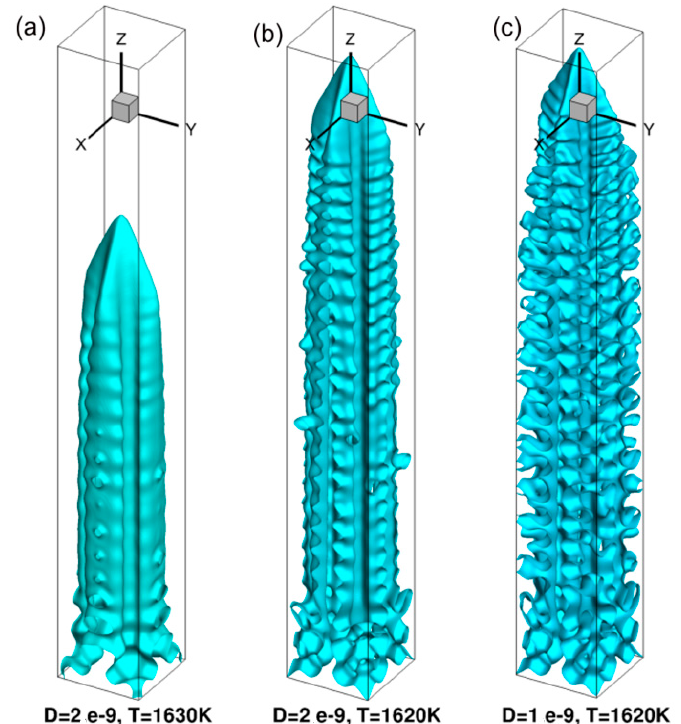
Figure 9. Dendrite morphologies in 3D obtained for ( a ) D=2 e-9 m 2 /s and s-l interface temperature=1630K, ( b ) D=2 e-9 m 2 /s and s-l interface temperature =1620K and ( c ) D=1 e-9 m 2 /s and s-l interface temperature =1620K and in the presence of a superimposed noise of sd = 1000 with a temperature gradient of 2.6 × 10 6 K/m in the liquid.